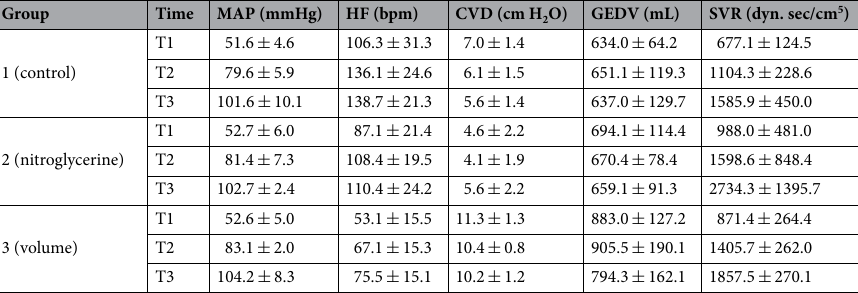
Table 1. Hemodynamic parameters. MAP mean arterial pressure, HR heart rate, CVP central venous pressure, GEDV global end-diastolic volume, SVR systemic vascular resistance, T1 hypotension (MAP < 60 mmHg); T2 significantly lower in group 2 compared to groups 1 and 3 (p < 0.05). MAP was significantly different between all measurement times (p <